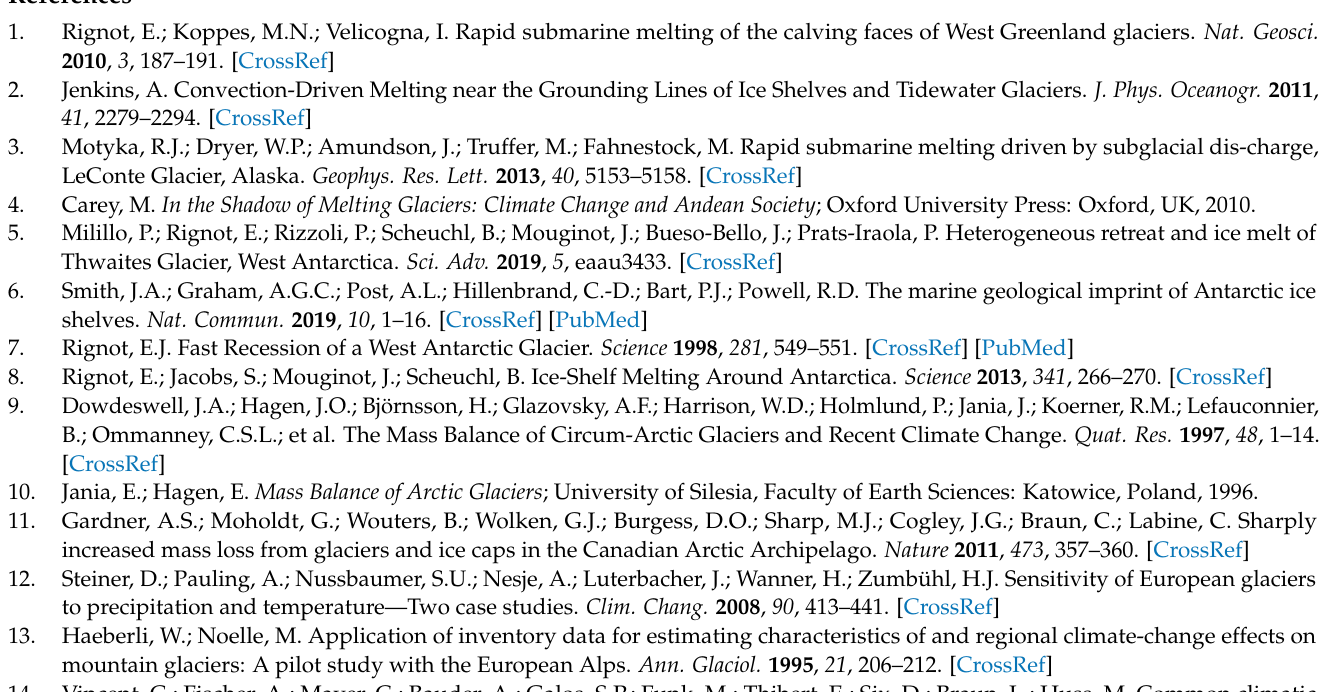
Figure S2: Location of the pictures and measurements, Figure S3: Location of photogrammetry control